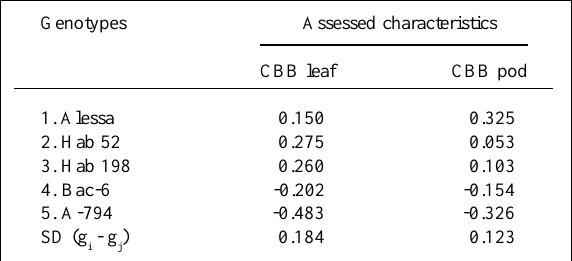
Table IV - Estimates of the general combining ability (g ) for reaction to i common bacterial blight (CBB) in leaves and pods assessed in five Phaseolus vulgaris L. genotypes and the standard deviations (SD) of the effects of two different parents.